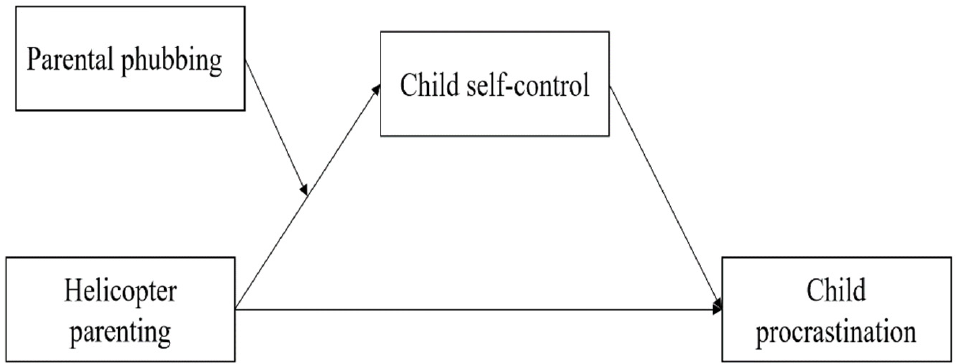
Figure 2. Hypothetical model with moderated mediation effects.